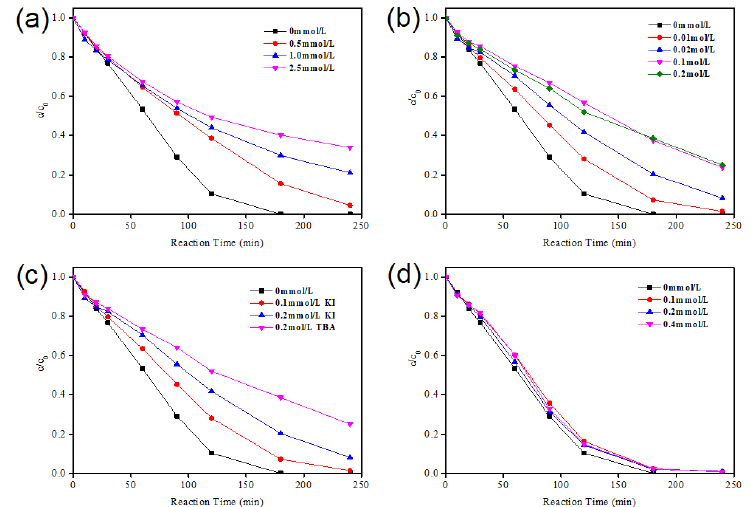
Figure 10. Effects of different types of free radical trapping agents on degradation of rhodamine B: ( a ) Ascorbic acid; ( b ) TBA; ( c ) KI and TBA; ( d ) P-benzoquinone( c 0 = 200 mg/L, c H T = 55 °C, catalyst = 10 g/L, pH = 3).